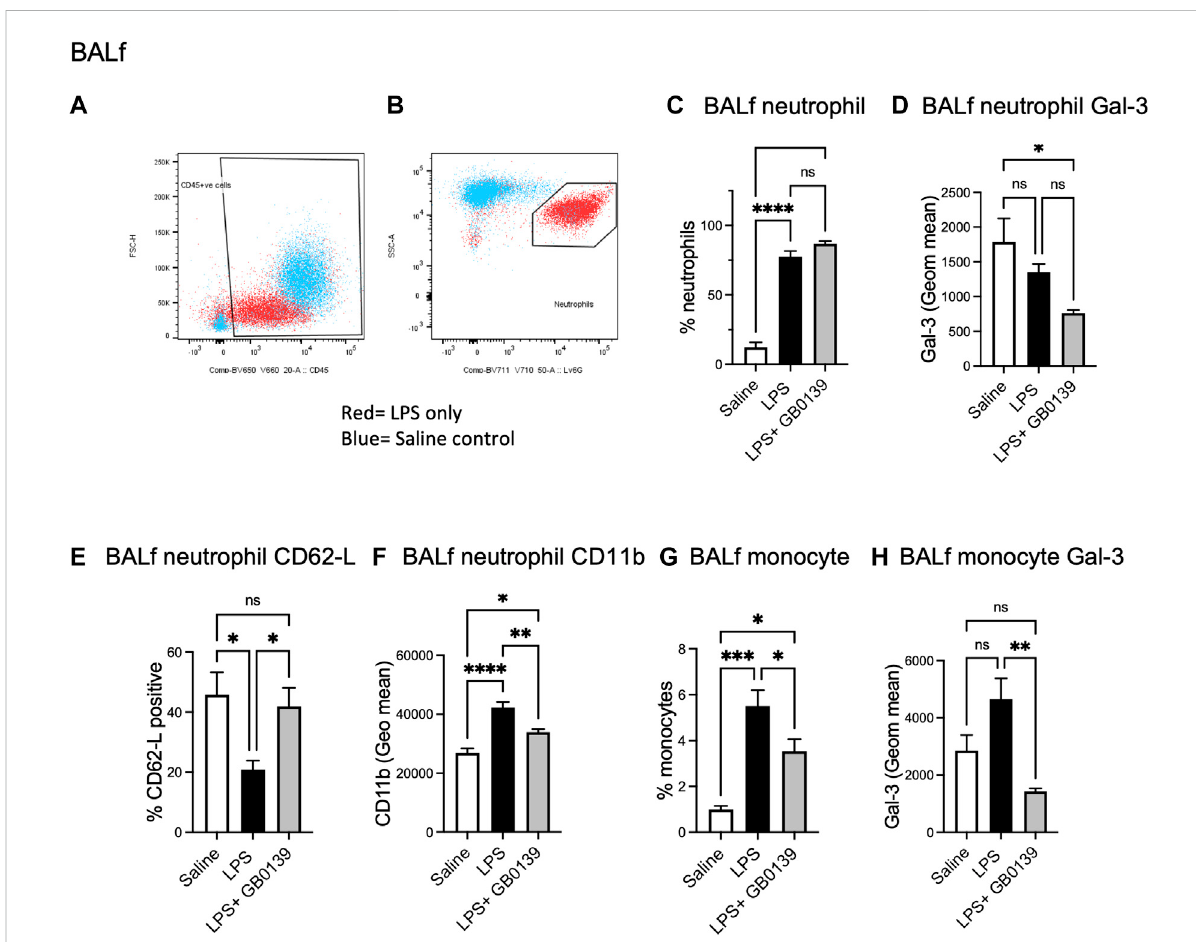
FIGURE 4 Flow cytometric analysis of BALf following LPS-induced lung in fl ammation. 10 µg LPS was administered alongside 30 μ g GB0139 i.t. and tissue retrieved 24 h later. (A – B) Gating strategy to identify CD45 + cells (left panel) and LY-6G + neutrophils (right panel) in BALf. (C) BALf neutrophil numbers, (D) Gal-3expressionand (E – F) activation parameters(CD62LandCD11b). (G – H) BALf monocytesand Gal-3expression.Datarepresented as mean ± SEM. Analysed via 1-way ANOVA (n = 6, * p < 0.05, ** p < 0.01, *** p < 0.001, **** p < 0.0001). ANOVA = analysis of variance; BALf = broncho-alveolar lavage fl uid; Gal-3 = galectin-3; h = hours; i.t. = intra-tracheal; LPS = lipopolysaccharide; SEM = standard error of the